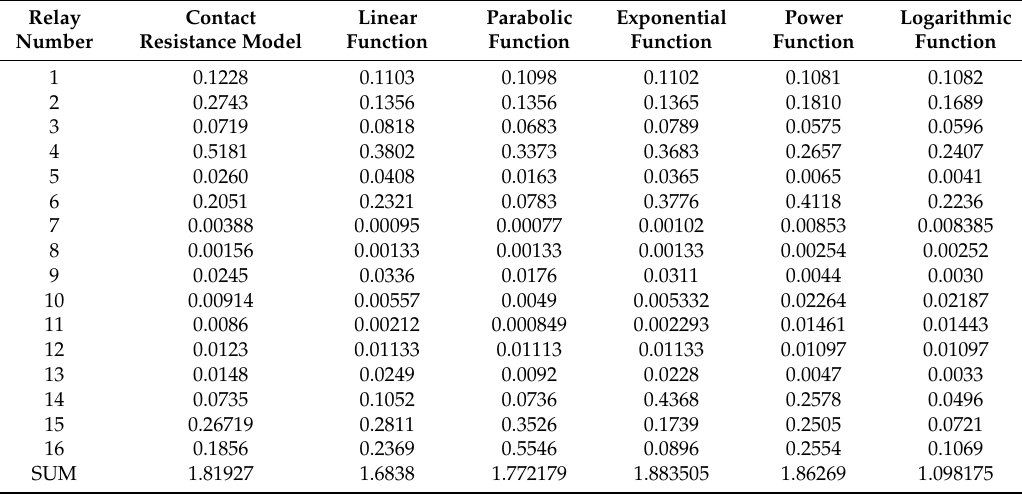
Table 2. The residual sums of squares.